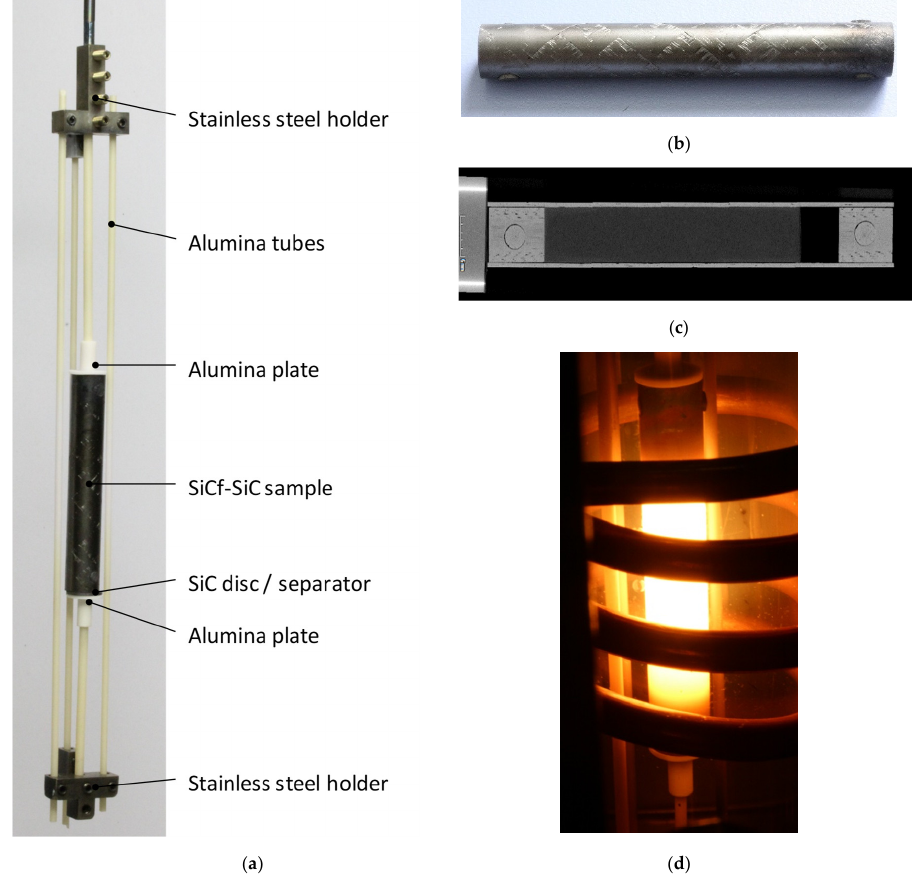
Figure 2. QUENCH-SR facility and SiC f -SiC sample. ( a ) Sample holder; ( b ) SiC f /SiC sample before test; ( c ) SiC f -SiC sample before test (tomography); ( d ) Sample in QUENCH-SR rig at 1700